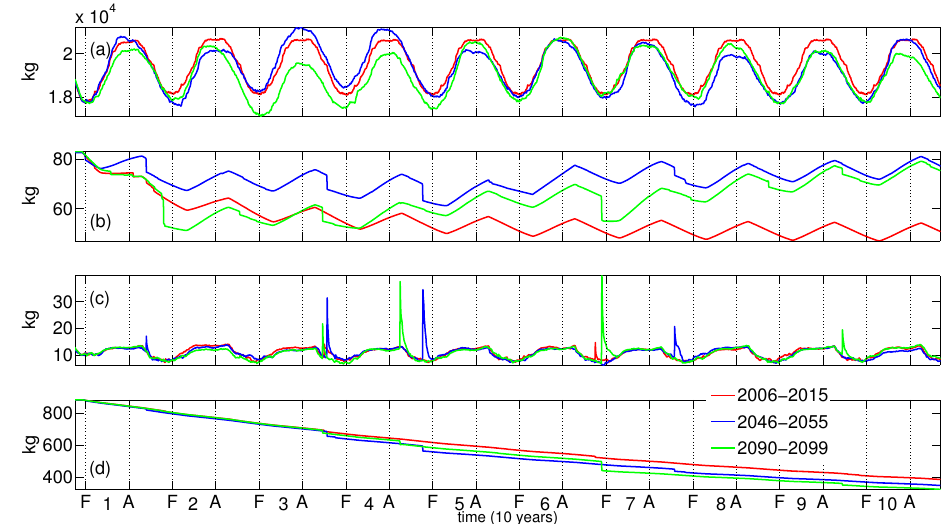
Figure 6. Time series of total mass of γ -HCH in water (a) , and sediment (b) , and PCB 153 in water (c) , and sediment (d) , for the three 10-year periods 2006–2015, 2046–2055 and 2090–2099. February and August (F and A) and the year number (1–10) are shown on the x axis. The time series presented in this paper are the sum values within the model